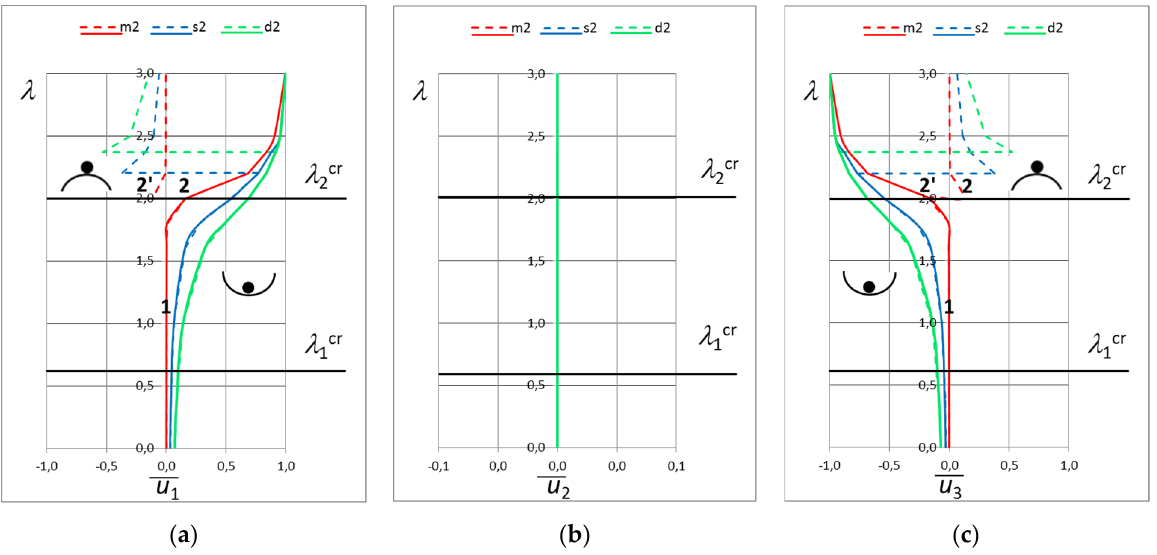
Figure 9. Equilibrium path obtained for small, medium and large amplitudes of the geometric imperfections in the shape of second buckling mode, respectively ( m 2, s 2 and d 2); displacement of the node: ( a ) No. 1, ( b ) No. 2, ( c ) No. 3.